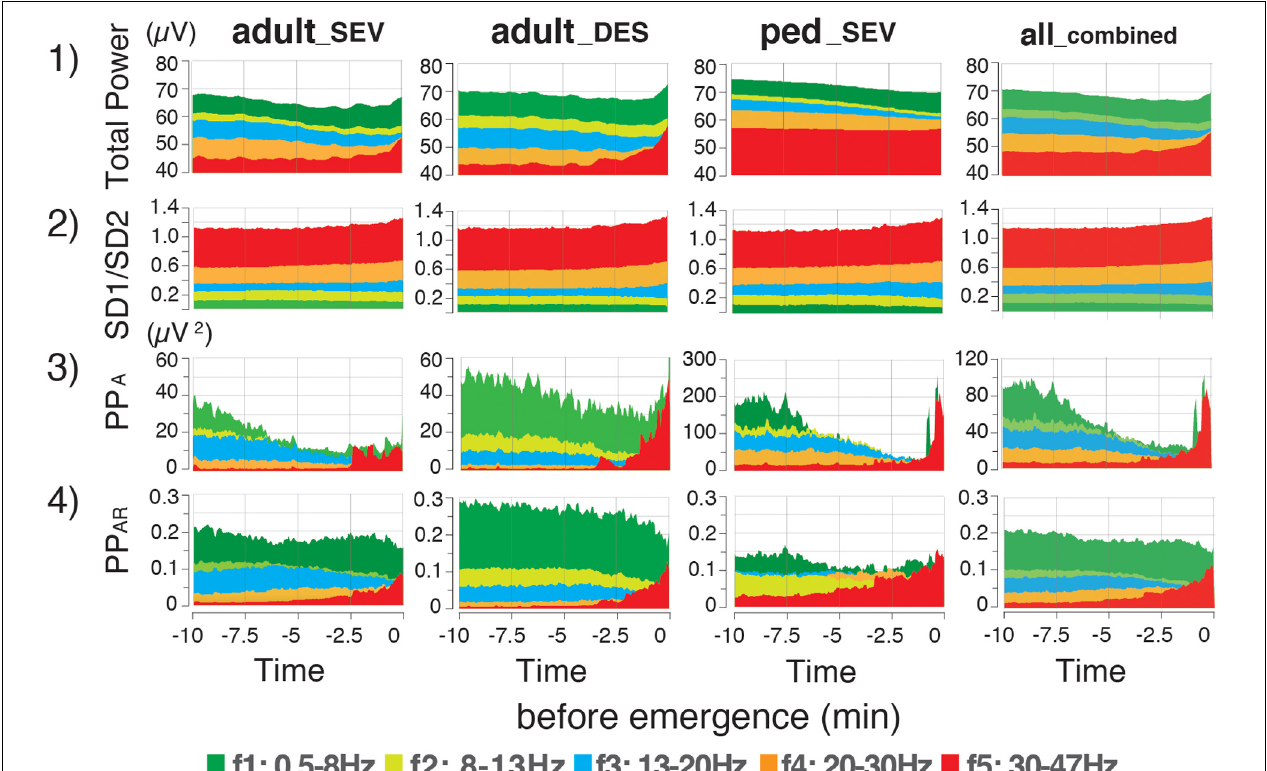
FIGURE 5 | Time-course changes of mean values of EEG parameters in the adult _ SEV , adult _ DES , and ped _ SEV groups, and etAG in the all _ combined group. Mean values of (1) total power, (2) SD1/SD2 of the Poincaré plot, (3) Poincaré plot area (PP A ), and (4) Poincaré plot-area ratio (PP AR : PP A of each frequency-range/PP A value of the f0:0.5–47 Hz range) throughout the time course from the hypnotic condition to the awake state. Data are shown as means. adult _ SEV , adults anesthetized with sevoflurane ( n = 20); adult _ DES , adults anesthetized with desflurane ( n = 20); ped _ SEV , pediatric patients anesthetized with sevoflurane ( n = 20); all _ combined group, all patients from the three groups ( n = 60). Plots of the time course range from the hypnotic condition (EM - 10 ) to the awake state (EM 0 ). EM - 10 , 10 min before emergence; EM 0 , at the time of emergence; PP AR , Poincaré plot-area